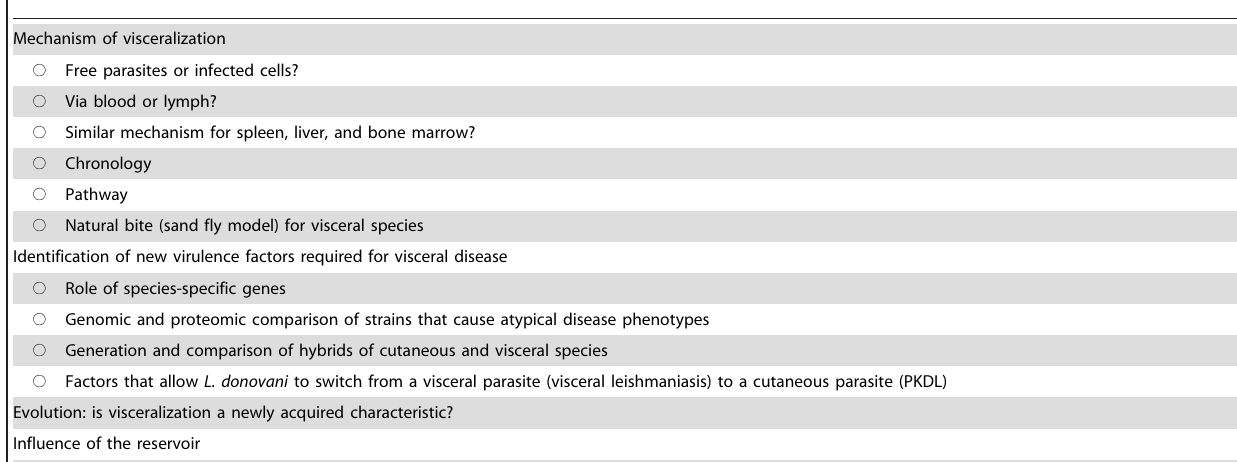
Table 3. Unresolved questions.